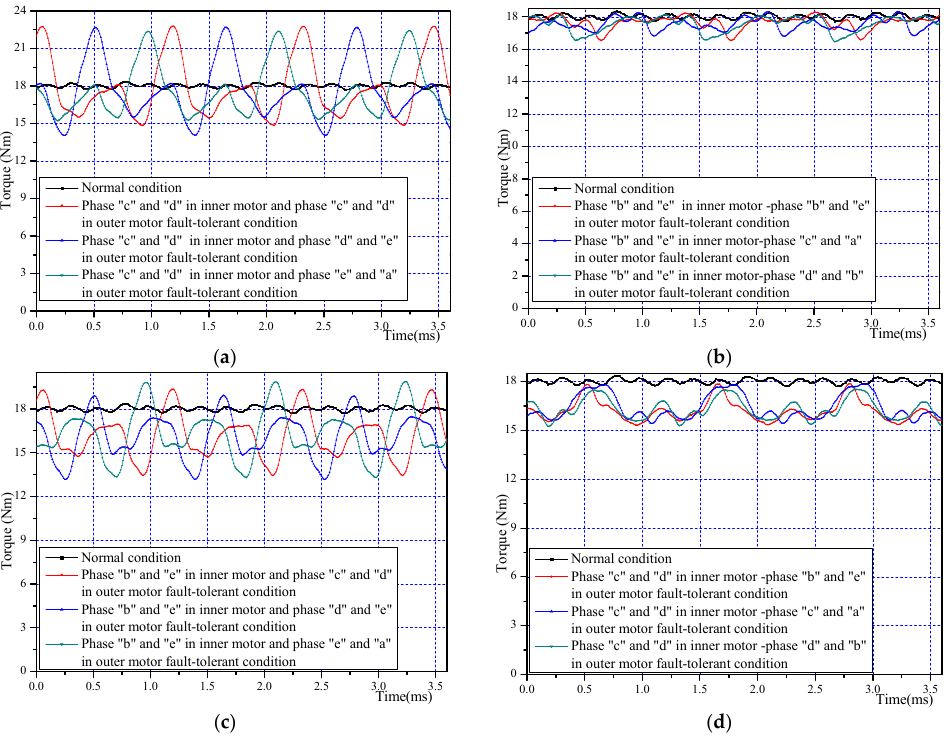
( d ) Figure 26. Double ‐ phase open ‐ circuit in both sides of motor fault types. ( a ) Adjacent double ‐ phase open ‐ circuit in outer motor and in inner motor; ( b ) non ‐ adjacent double ‐ phase open ‐ circuit in outer motor and in inner motor; ( c ) adjacent double ‐ phase open ‐ circuit in inner motor with non ‐ adjacent double ‐ phase open ‐ circuit in outer motor; ( d ) non ‐ adjacent double ‐ phase open ‐ circuit in inner motor with adjacent double ‐ phase open ‐ circuit in outer motor. In fault type (I), phases “c” and “d” in inner motor and phase “c” and “d” in outer motor being open ‐ circuit is one fault case, while phase “c” and “d” in inner motor and phase “d” and “e” in outer motor being open ‐ circuit is the other fault case, and phase “c” and “d” in inner motor and phase “e”